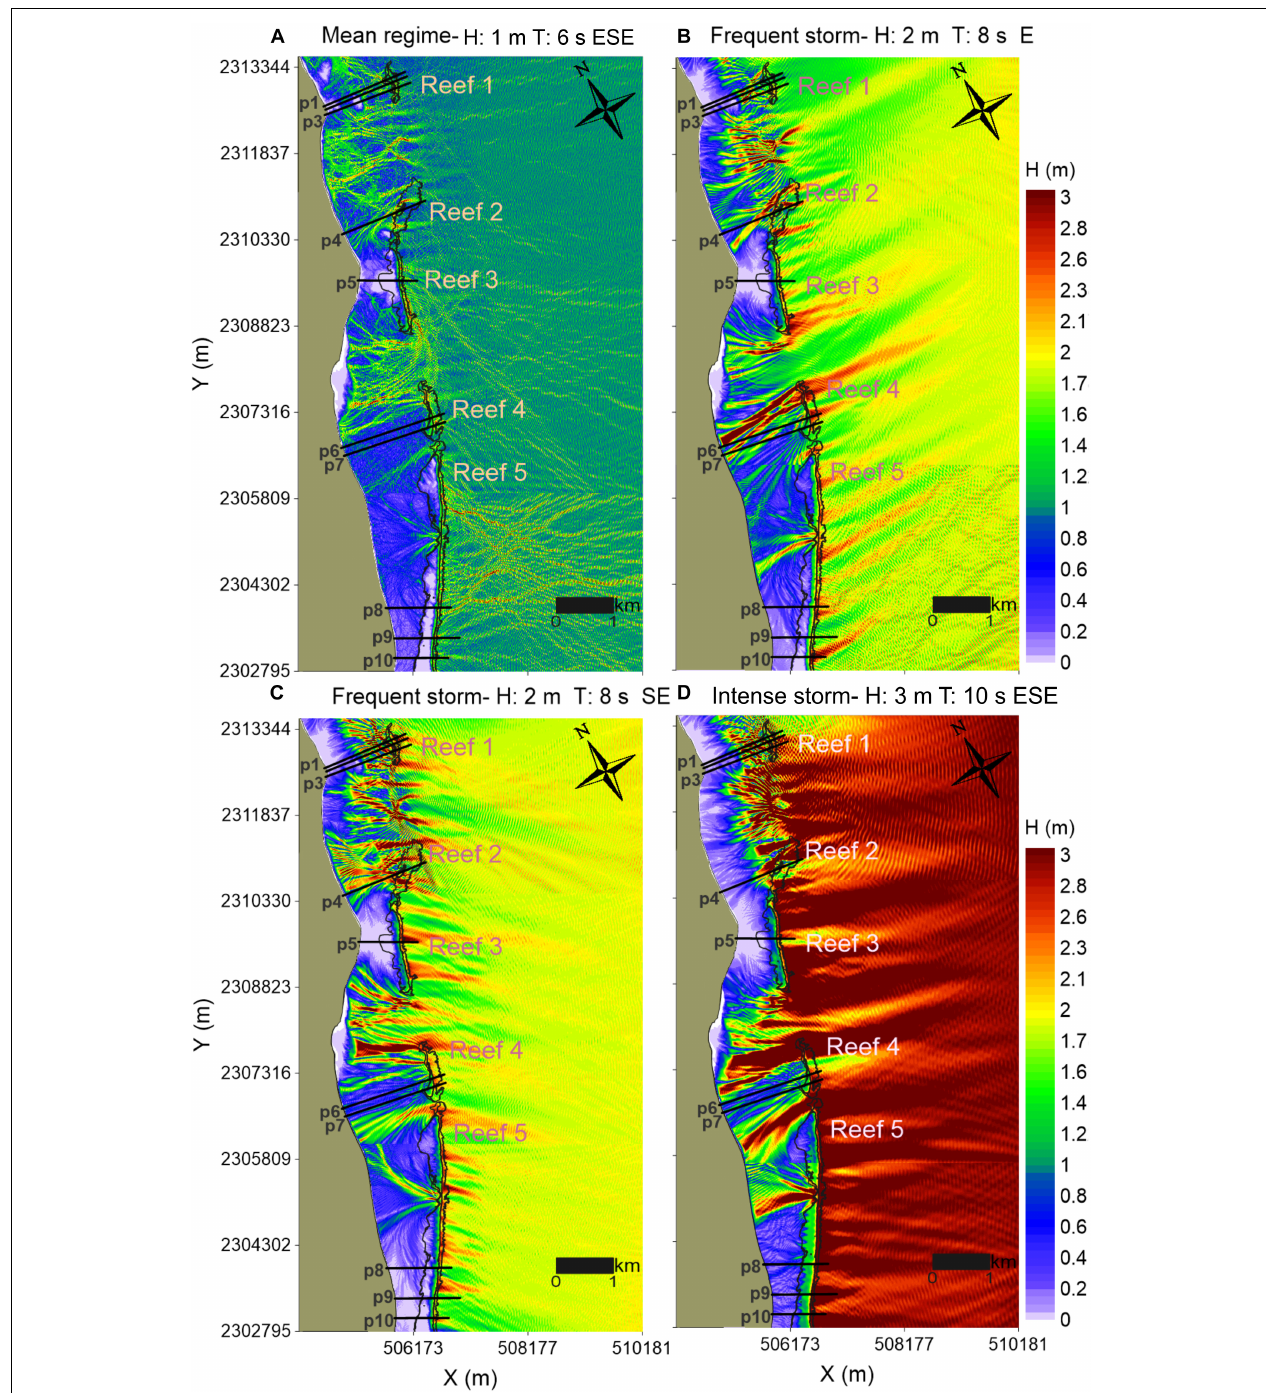
FIGURE 8 | Maps showing maximum wave heights for storm and non-storm wave scenarios: (A) Mean regime-H: 1 m T: 6 s ESE. (B,C) Frequent storms- H: 2 m T: 8 s E/SE. (D) Intense storm- H: 3 m T: 10 s ESE.